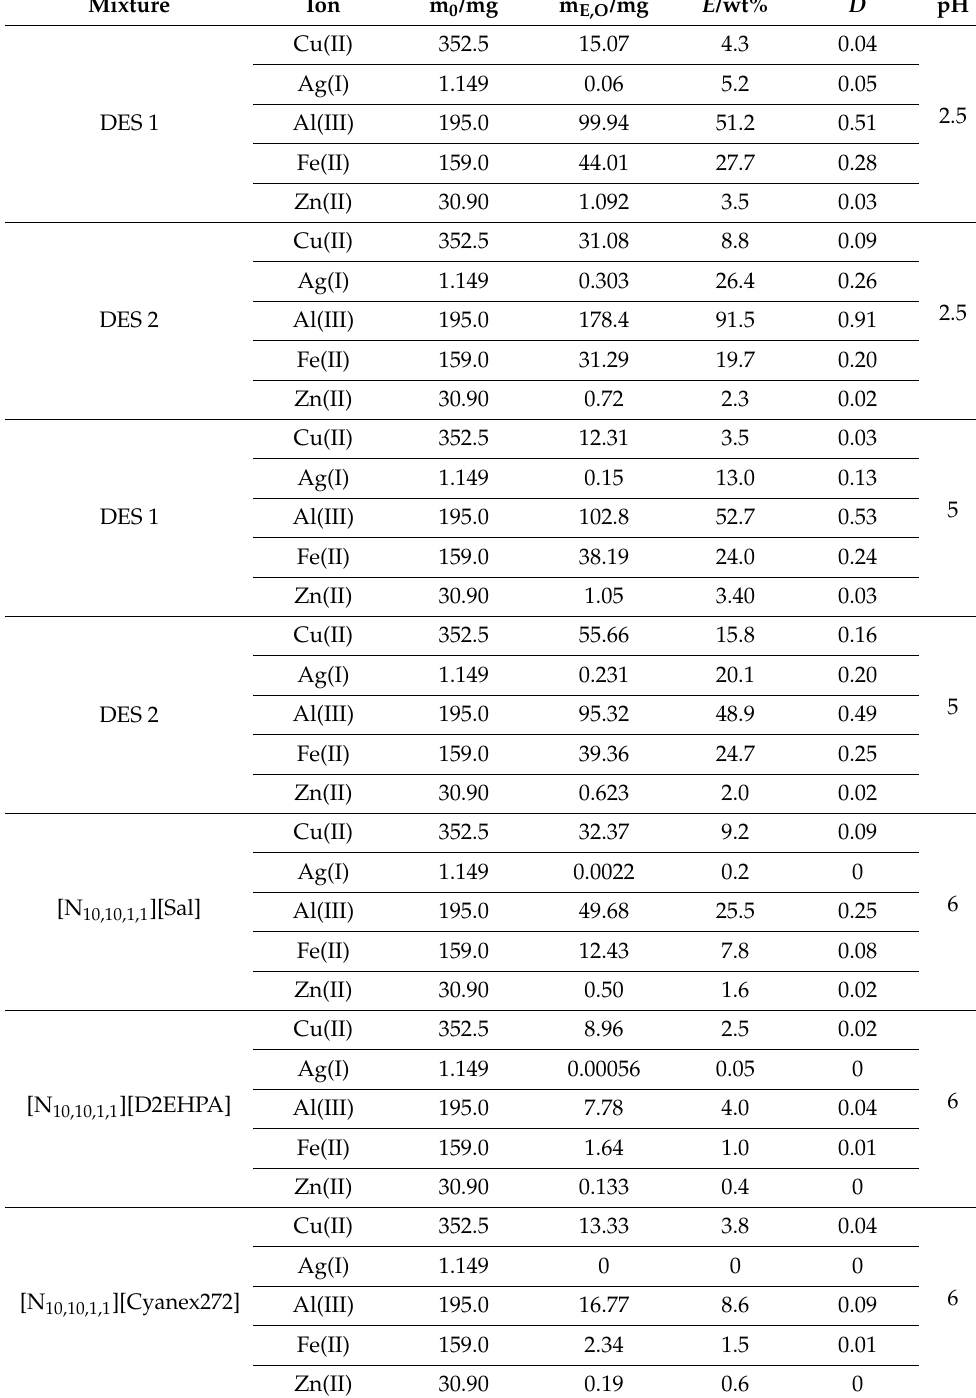
Table 9. Results of metals extraction from the solid WPCBs material after thermal pre-treatment ( T = 1023 K, 7 h) and the I leaching {4M H 2 SO 4 + 100 g/dm 3 (NH 2 ) 2 CS + 13 g/dm 3 Fe 2 (SO 4 ) 3 }, with DESs and bi-functional ILs, extraction efficiency ( E /wt%), distribution ratio ( D ) and pH of the aqueous phase after